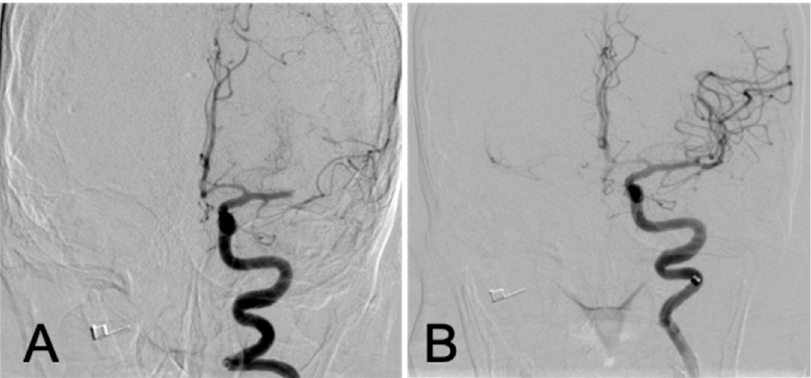
Figure 1. First thrombectomy, PA views: left M1 middle cerebral artery occlusion before ( A ) and after ( B ) successful mechanical thrombectomy.